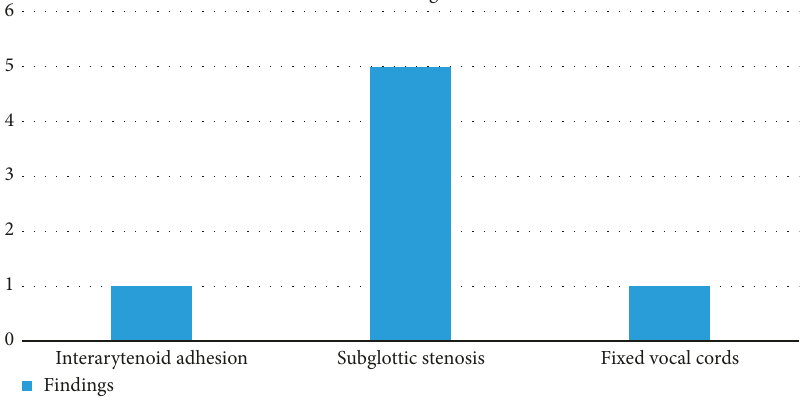
Figure 13: Findings/type of stenosis. Patients